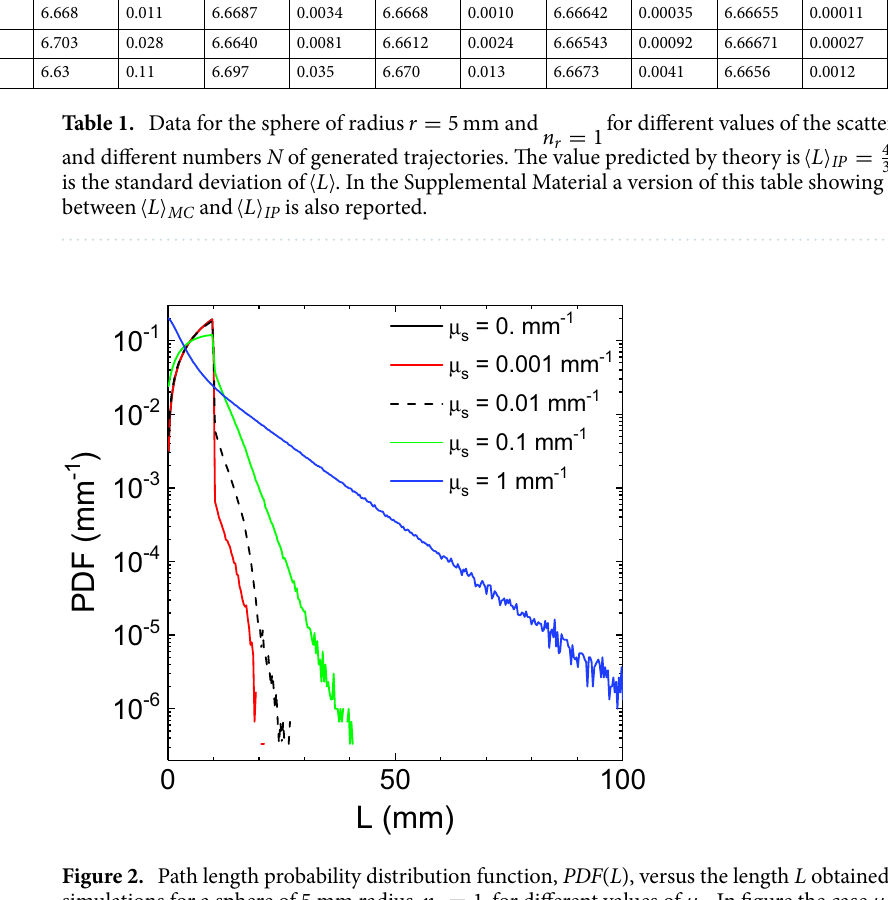
1 , for different values of µ 0 is s . In figure the case µ s = = 1 for L < 10 mm, while being the ballistic component is zero for